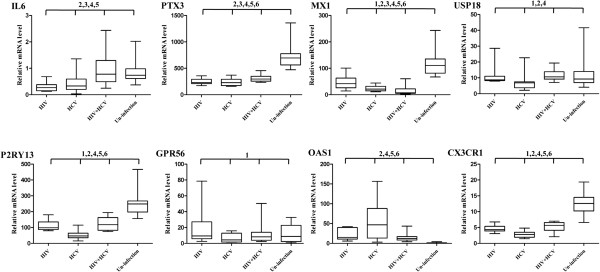
Quantitative real time RT-PCR validations of differentially expressed genes. The mRNA levels of selected genes were measured in HCV, HIV co-/mono-infected individuals (16 individuals in each group) by quantitative real time RT-PCR. And the relative mRNA value was calculated as described in methods. Box-plot illustrated the medians with 25% and 75%; error bars indicate 5% and 95% percentiles. 1–6 represent comparisons between HCV infection and HIV infection, HCV and HIV/HCV co-infection, HIV and HIV/HCV co-infection, HCV infection and uninfection, HIV infection and uninfection, and HIV/HCV co-infection and uninfection with p < 0.05, respectively.